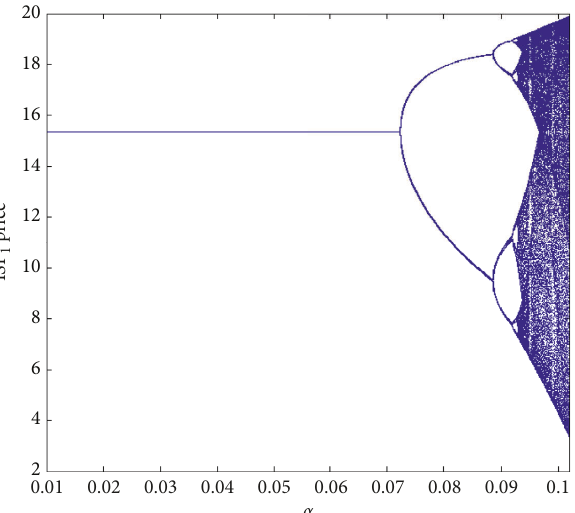
Figure 7: Bifurcation diagrams of p